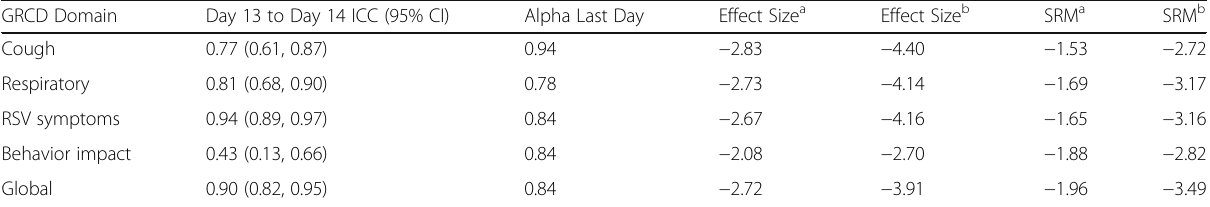
Table 2 GRCD Scores — Reliability and Responsiveness GRCD Domain